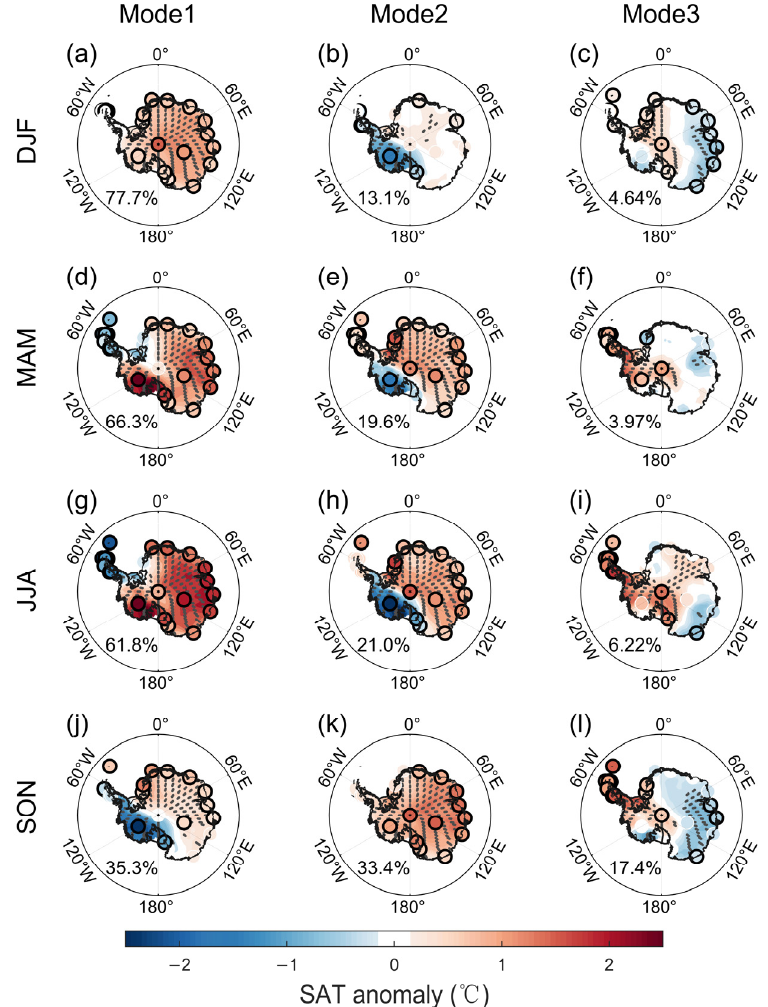
Figure 7. The spatial pattern of the first three modes of the combined maximum covariance analysis (CMCA) for austral summer, DJF ( a – c ), autumn, MAM ( d – f ), winter, JJA ( g – i ), and spring, SON ( j – l ). ( a , d , g , j ) show the spatial patterns for the ensemble mean of the reanalyses (color shadings) and observations (color dots) of the first CMCA mode in each season, while ( b , e , h , k ) and ( c , f , i , l ) represent the second and third CMCA modes, respectively. The gray scatters and dots with black edges represent significant SAT anomalies at p < 0.05.